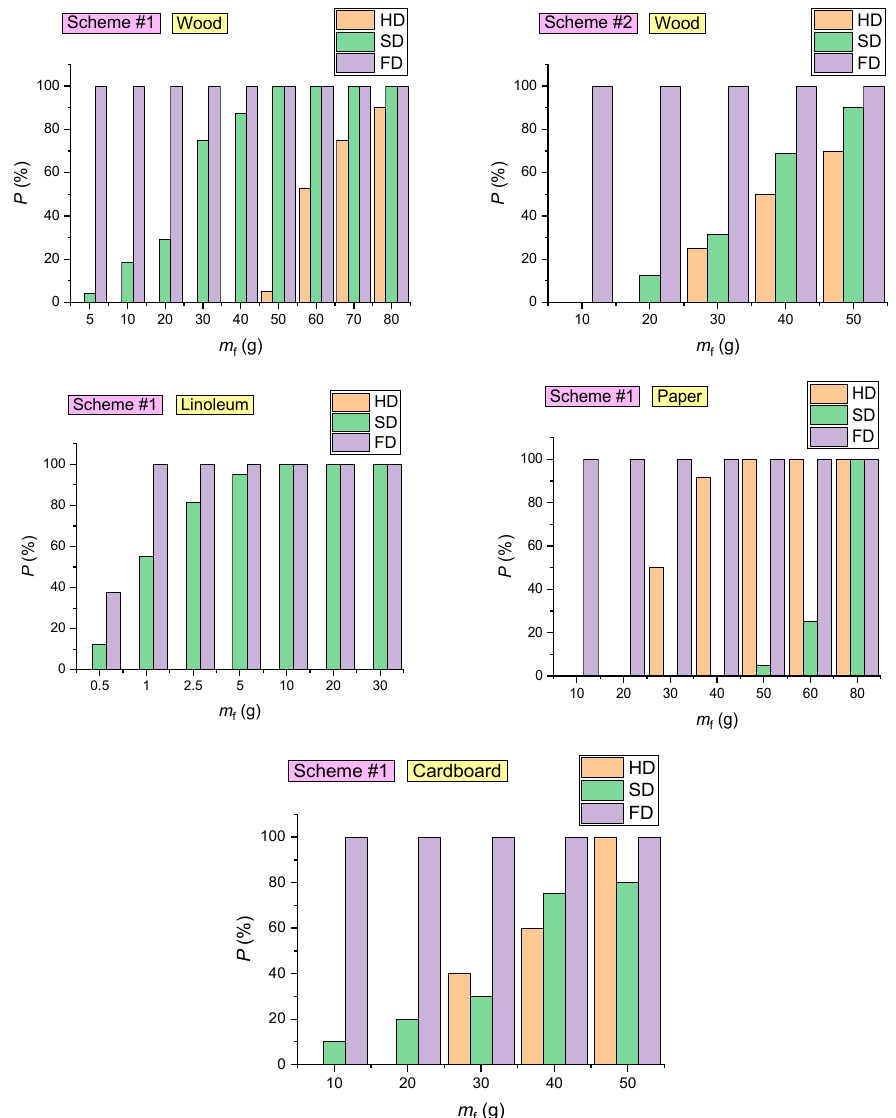
Figure 19. Probability of detector (FD, HD, SD) activation at different masses of the sample during the combustion of fuel materials (wood; linoleum; paper; cardboard).